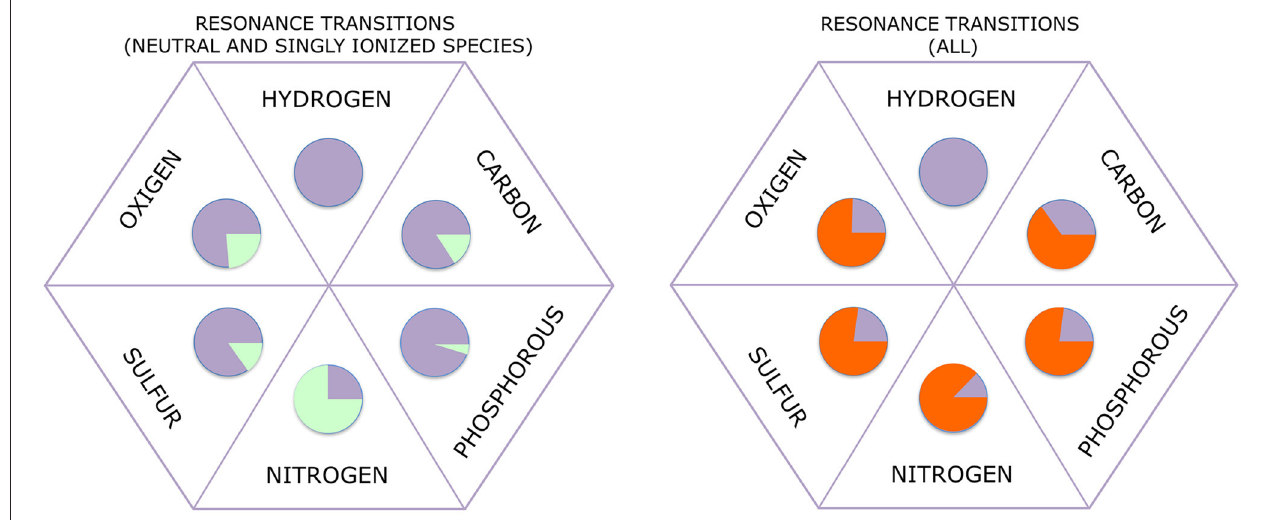
FIGURE 1 | Fraction of resonance transitions of the basic bio-elements observed in the 90–320nm spectral range. (Left) only resonance transitions of neutral and singly ionized species are considered; the percent of transitions in the 90–320nm is marked in violet; green otherwise. (Right ) Resonance transitions from all ionization states are considered; the percent of transitions in the 90–320nm is marked in violet; orange otherwise. As expected, resonance transition corresponding to high ionization states are observed at wavelengths shorter than 90nm.